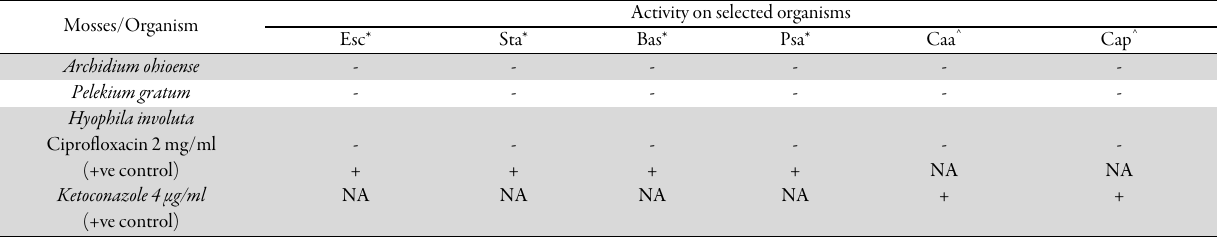
Table 1. Screening of antimicrobial activity of the methanolic extracts of Archidium ohioense, Pelekium gratum, Hyophila involuta against different microorganisms